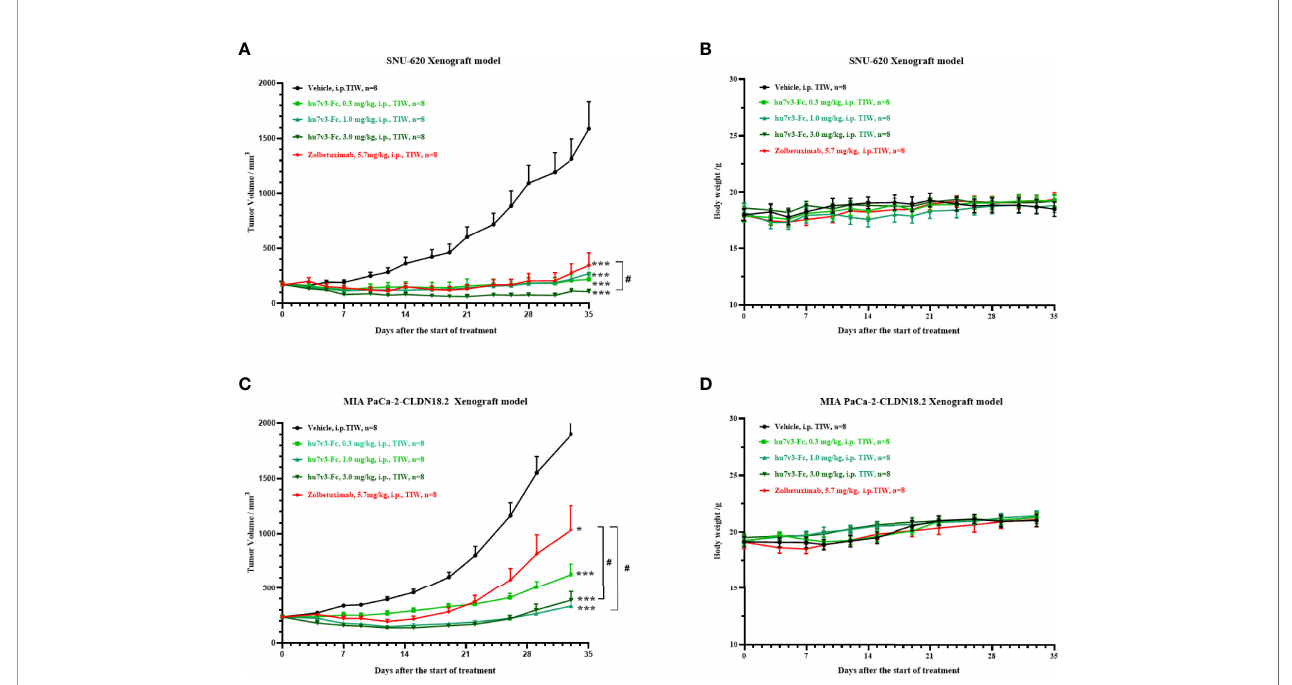
FIGURE 4 | In vivo tumor inhibition ef fi cacy of anti-CLDN18.2 7v3-Fc. (A, C) Tumor growth curves of SNU-620 and MIA PaCa-2-CLDN18.2 bearing mice injected with different formulations, respectively. (B, D) Body weight changes of SNU-620 and MIA PaCa-2-CLDN18.2 bearing mice injected with different formulations, respectively.Data are shown as mean ± SEM, n = 8, *p < 0.05, ***p < 0.001 (vs Vehicle); # p< 0.05 (vs Zolbetuximab).